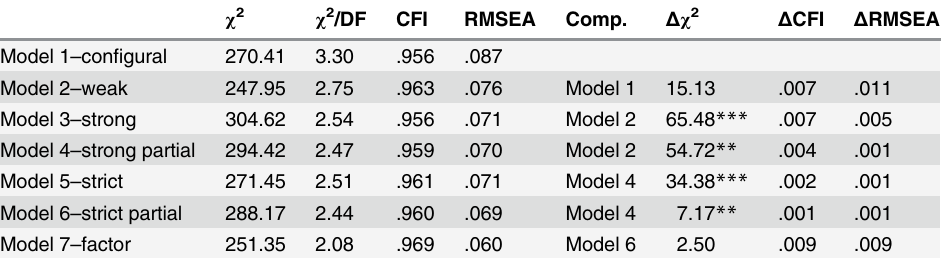
Table 10. Summary for the goodness of fit statistics for models on the measurement invariance test- ing of gender. χ 2 χ 2 /DF CFI RMSEA Comp. Δ χ 2 Δ CFI Δ RMSEA Model 1 – con fi gural 270.41 3.30 .956 .087 Model 2 – weak 247.95 2.75 .963 .076 Model 1 15.13 .007 .011 Model 3 – strong 304.62 2.54 .956 .071 Model 2 65.48 *** .007 .005 Model 4 – strong partial 294.42 2.47 .959 .070 Model 2 54.72 ** .004 .001 Model 5 – strict 271.45 2.51 .961 .071 Model 4 34.38 *** .002 .001 Model 6 – strict partial 288.17 2.44 .960 .069 Model 4 7.17 ** .001 .001 Model 7 – factor 251.35 2.08 .969 .060 Model 6 2.50 .009